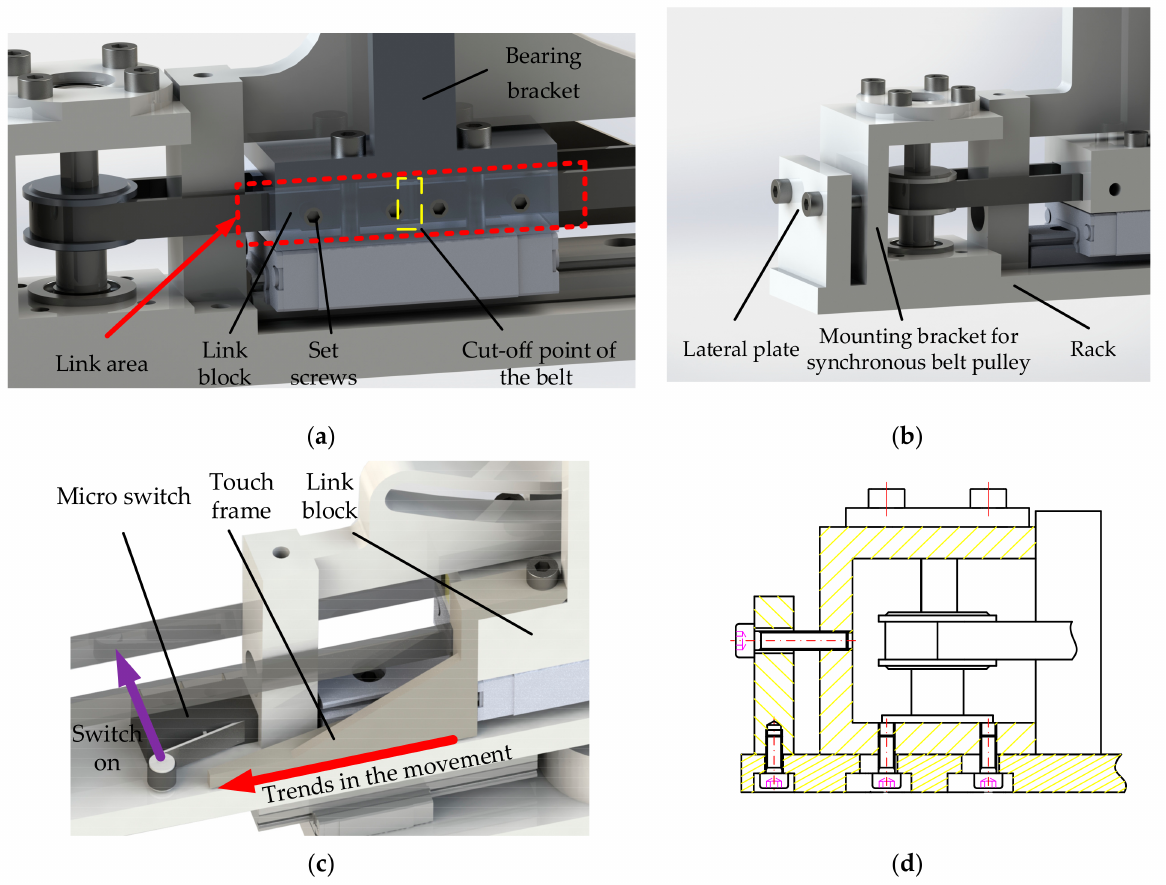
Figure 8. Necessary details of the module. ( a ) The synchronous belt and the link block; ( b ) the tensioning structure; ( c ) the limit switches; ( d ) drawings of the tensioning structure.